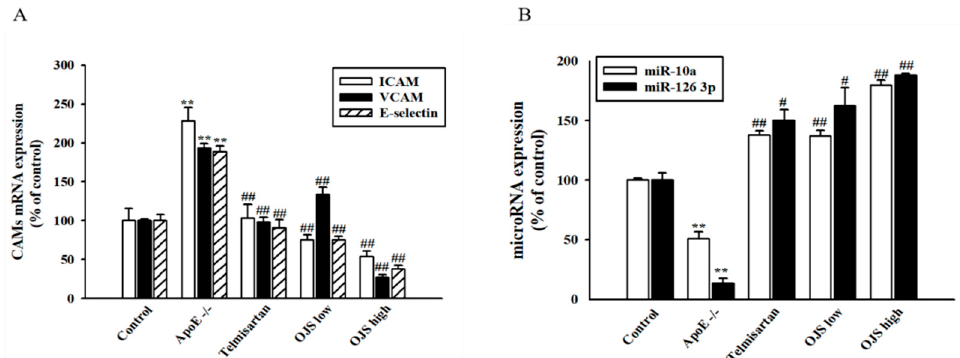
Figure 6. Effects of OJS on miR-10a and miR-126 3p expression in the aorta of ApoE − / − mice. mRNA expression of adhesion molecules determined by real-time Reverse Transcription-PCR (RT-qPCR) analysis ( A ). Levels of miRNA determined by real-time RT-qPCR ( B ). Data are presented as means ± S.E. ** p < 0.01 vs. control group; # p < 0.05, ## p < 0.01 vs. ApoE − / − group.